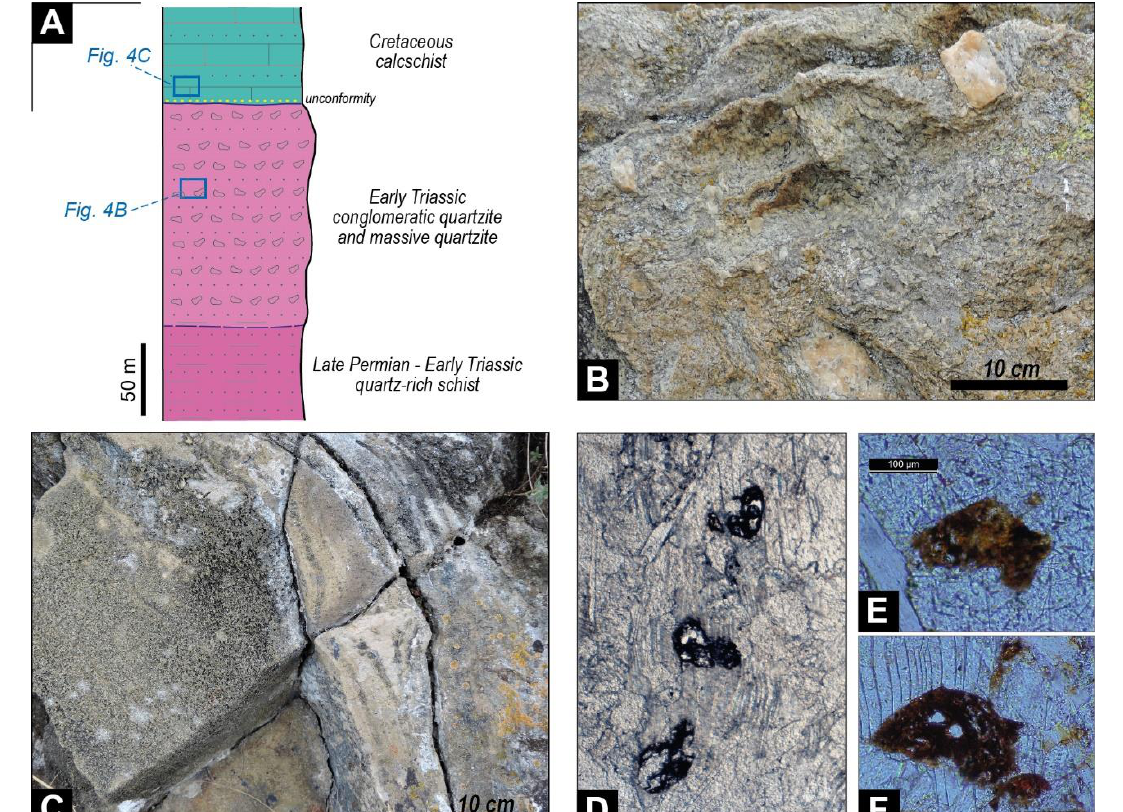
Figure 4. ( A ) Pre-alpine stratigraphic columnar section of the Sampeyre Unit (the stratigraphic location of the representative field images is shown); ( B ) close-up view of the Early Triassic conglomeratic quartzite with centimers-sized clasts of quartz (South-East of Mt.Rastcias); ( C ) close-up view of the Cretaceous calcschist bearing Globotruncana sp., which stratigraphically overlies the quartzite (South-East of Mt.Rastcias); ( D – F ) thin section images (plane polarized ligh) of the calcschist of Figure 4C, including aggregates of calcite and Fe-oxide replacing planktonic Foraminifera (i.e., Globotruncana sp.).